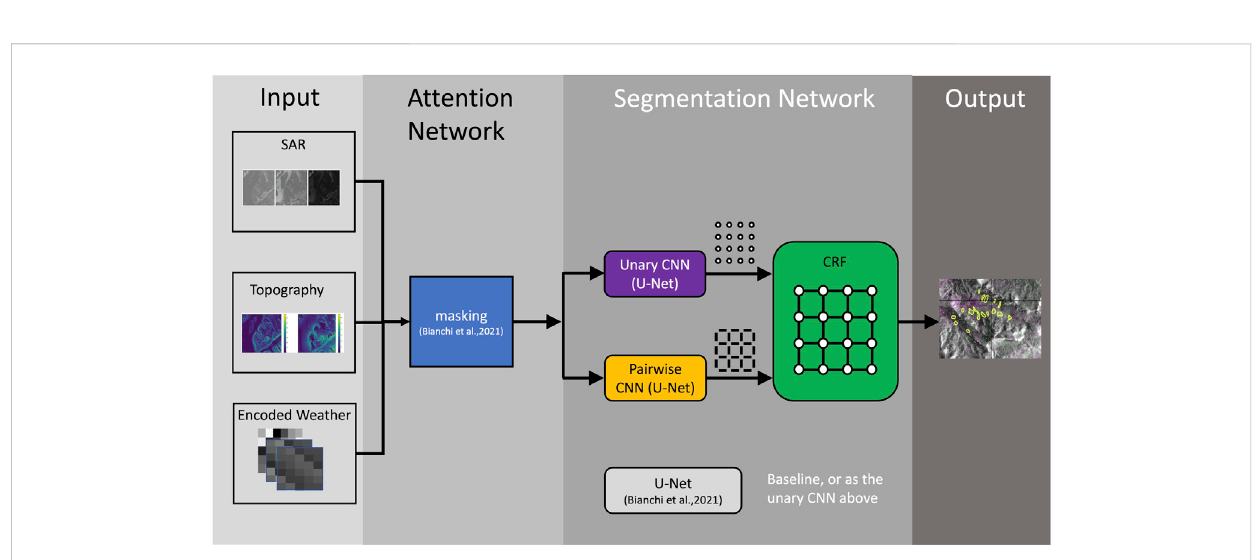
FIGURE 5 Overview of the architecture of the detection algorithm. The innovative parts are the inclusion of encoded weather data and a new segmentation network where CRF stands for conditional random fi eld, CNN for convolutional neural network and U-net is a special CNN architecture.